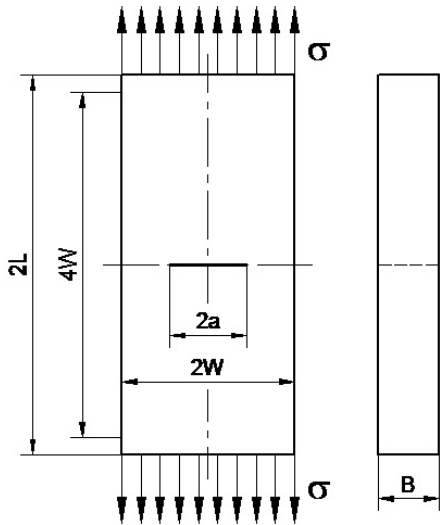
Figure 6. The centre cracked plate in tension – CC(T) specimen